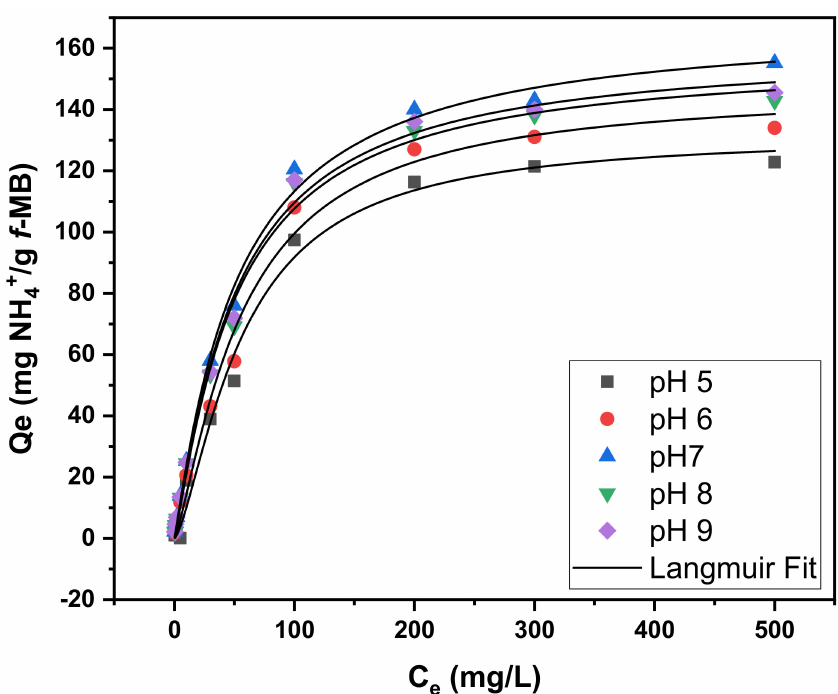
Figure 4. Experimental and calculated (Langmuir model) isotherms fitting of ammonium uptake by f -MB at different pH values. NH 4+ -N concentration 0.05–500 mg/L, adsorbent dose 0.2 g, aqueous solution: synthetic wastewater (SWW).